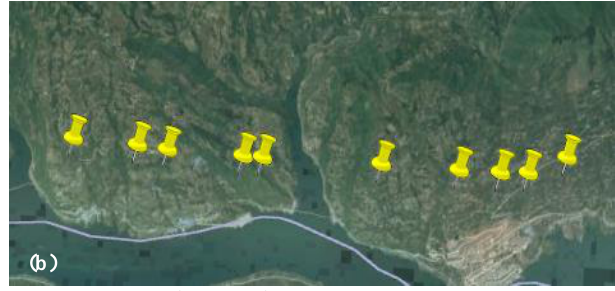
Figure 5. Identification of SAR UHV Transmission Towers